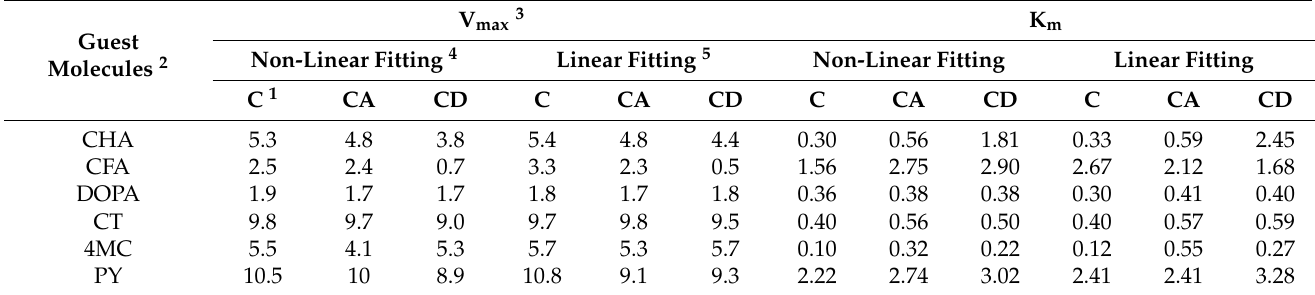
Table 2. Apparent kinetic parameters of tyrosinase toward PCs in the absence and presence of cyclic glucans. Guest Molecules